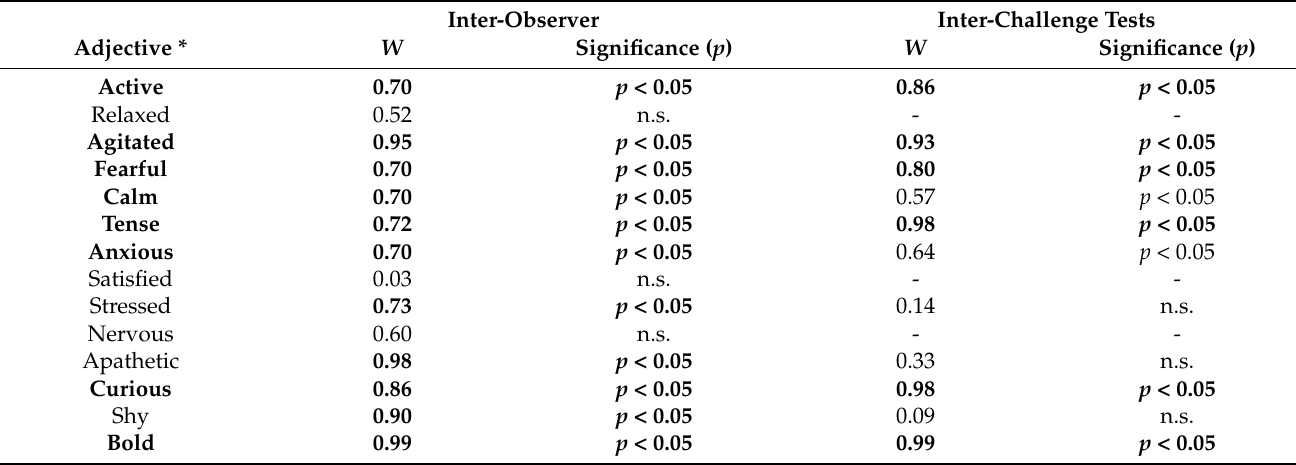
Table 3. Inter-observer and inter-challenge tests (novel object, novel-environment, and anti-predator) using Kendall’s concordance coefficients ( W ) of individual behavioural distinctiveness traits.